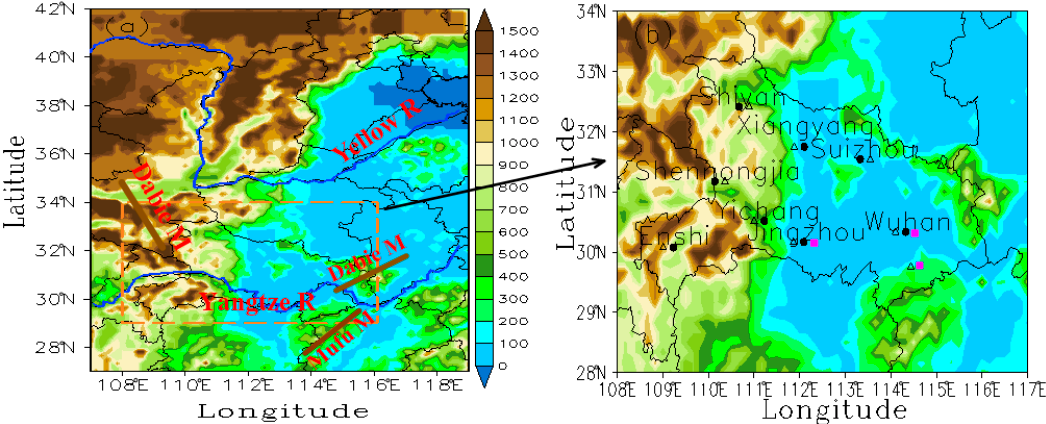
Figure 1. ( a ) Locations of the Hubei Province Region (HPR) (orange rectangle) and topography (shaded, m) over the HPR and its adjacent areas. Panel ( b ) is a zoomed-in area of the orange rectangle in ( a ) which shows the spatial distribution of the Doppler radar (black solid circle), Advanced Time of arrival and Direction systems (ADTDs) (black triangles) and microwave radiometer (MWR) (rose box) used in this study.